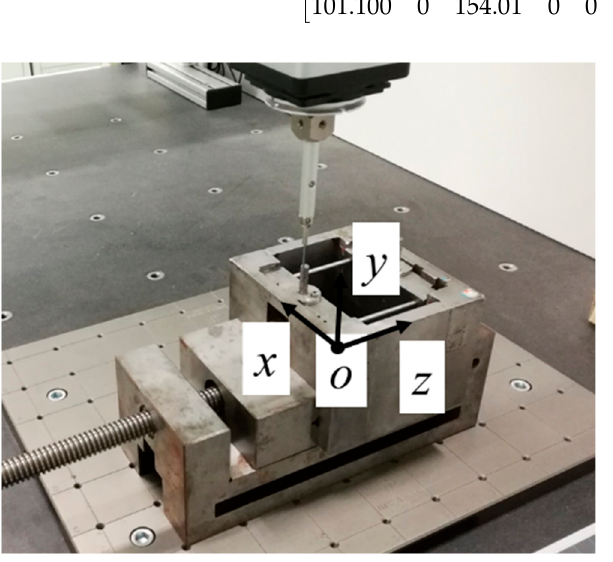
Figure 10. Reference coordinate system.